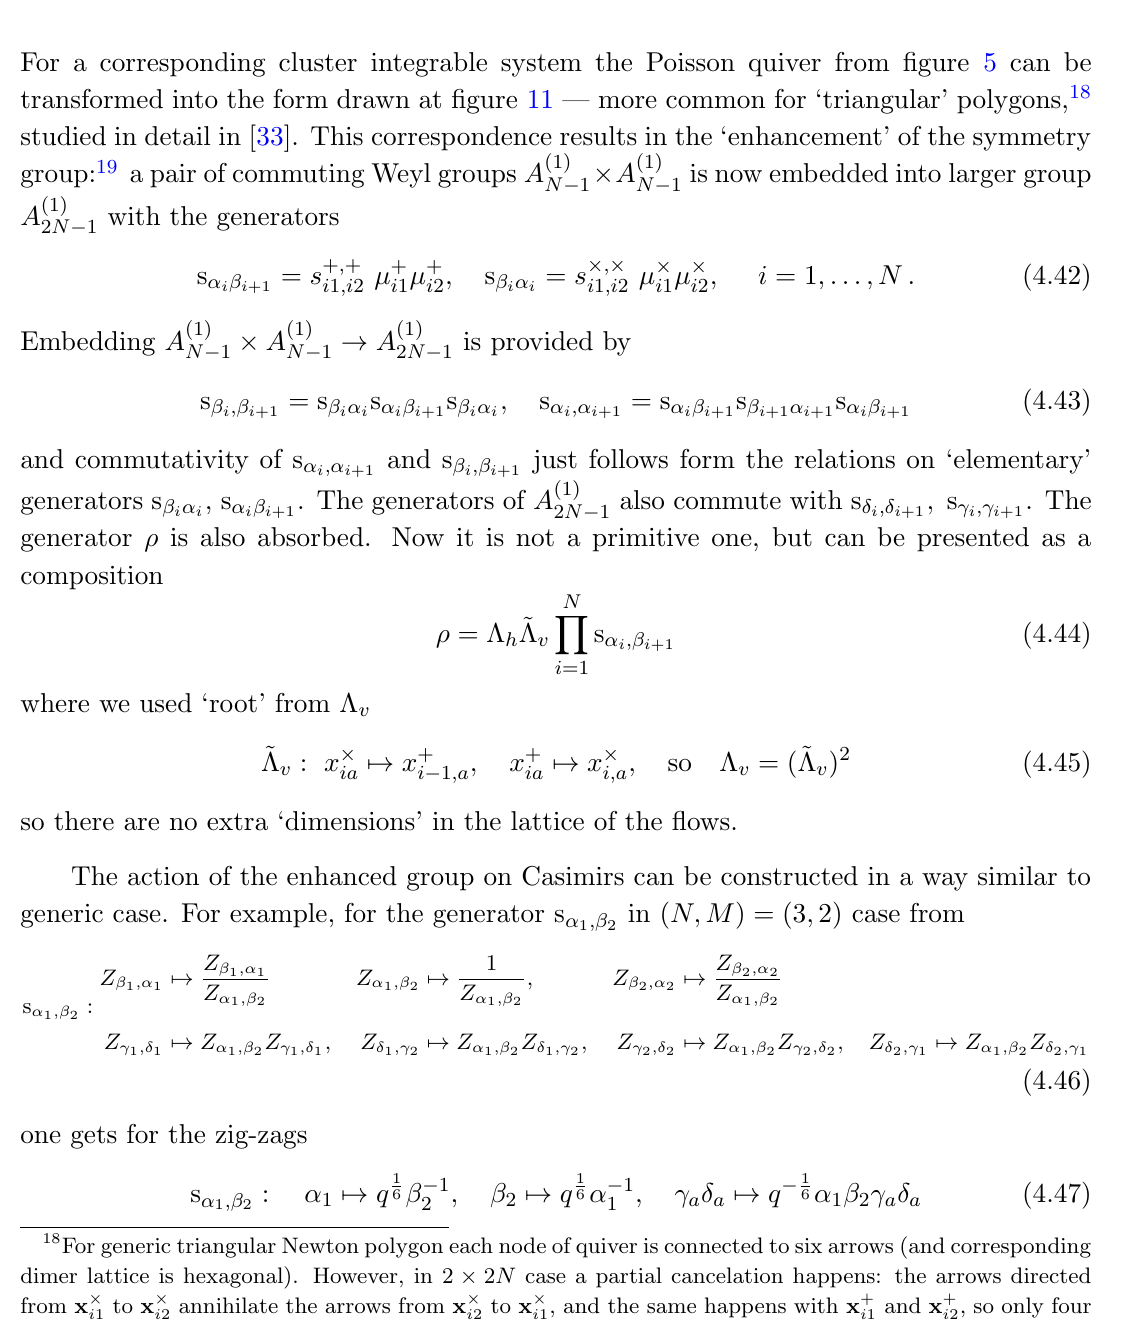
Figure 10 . Transformation from rectangle to triangle for (3 ; 2)